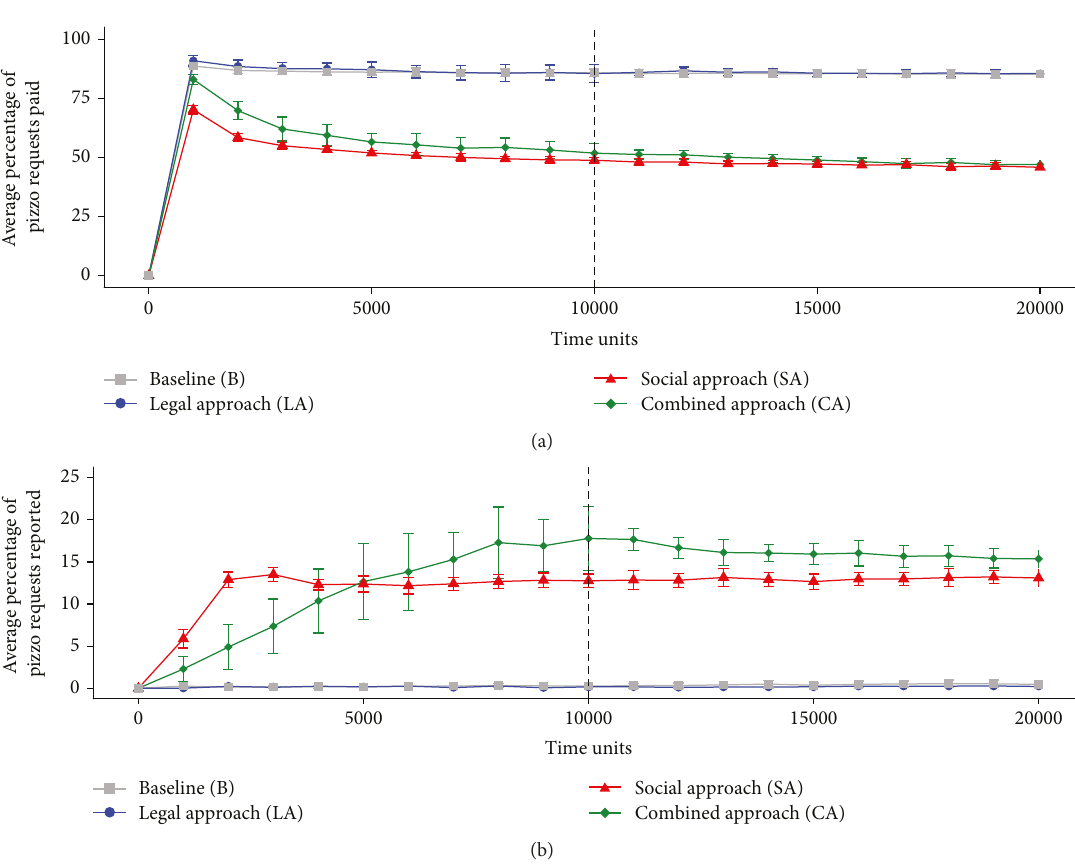
Figure 5: Entrepreneurs ’ actions. Means plotted and error bars indicate ± 1 standard deviation. The (a) proportion of pizzo requests paid and (b) reported in each treatment. The dashed line indicates the change to baseline